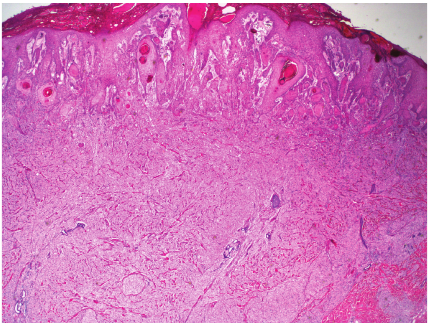
Figure 1: H&E, 20x magnification. Figure 2: H&E, 100x magnification.